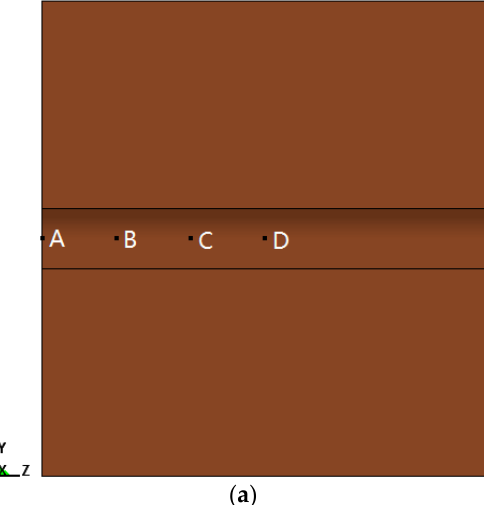
Figure 3. Grid division in finite element model.